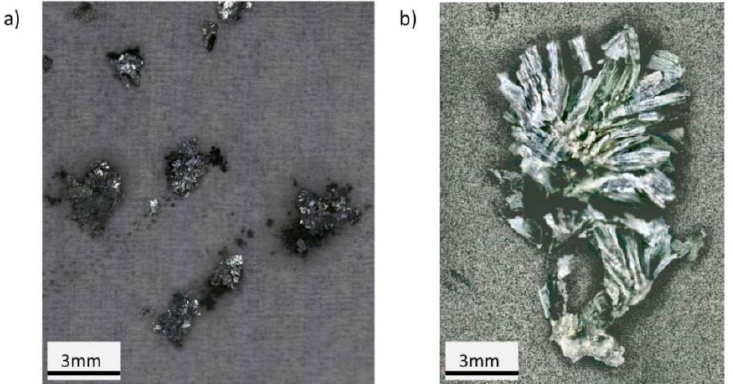
Figure 27. Illustration of abraded particle size of the galvanized DP600 under Zeiss microscope Smartzoom 5 ( a ) particles in experiment with nodular iron EN-GJS-700-2; ( b ) particle in experiment with cold working steel 1.2379.